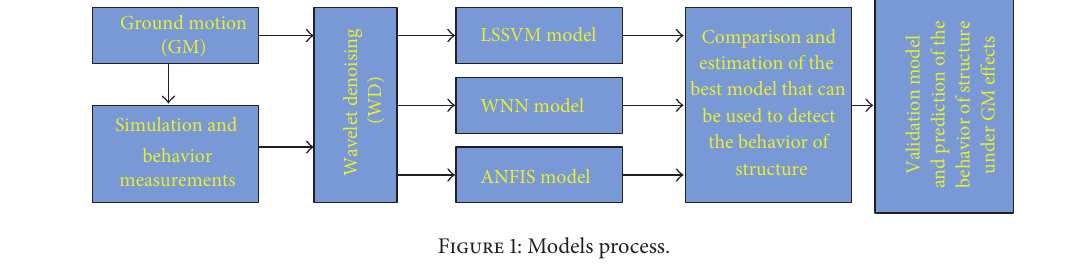
Figure 1: Models process.